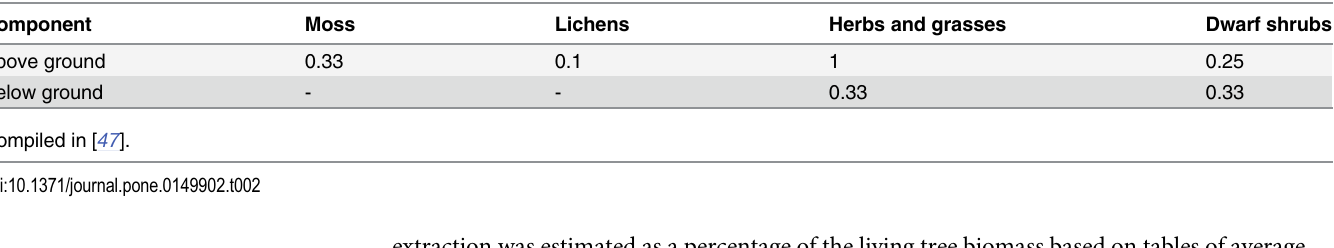
Table 2. Annual turnover rates (year -1 ) used to estimate litter input from ground